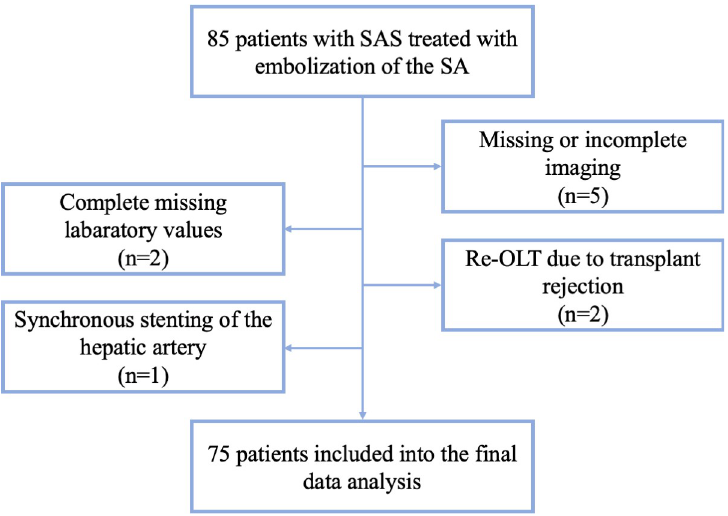
Fig 1. Exclusion flowchart. A total of ten patients were excluded. 75 patients were included in the final data analysis. Of these 75 patients a total of 60 patients had complete laboratory data during the 30-days follow up. 15 patients missing data but could be included into the linear mixed model regression analysis. SAS, Splenic Artery Steal Syndrome; SA, Splenic Artery; OLT, Orthotopic Liver Transplantation.